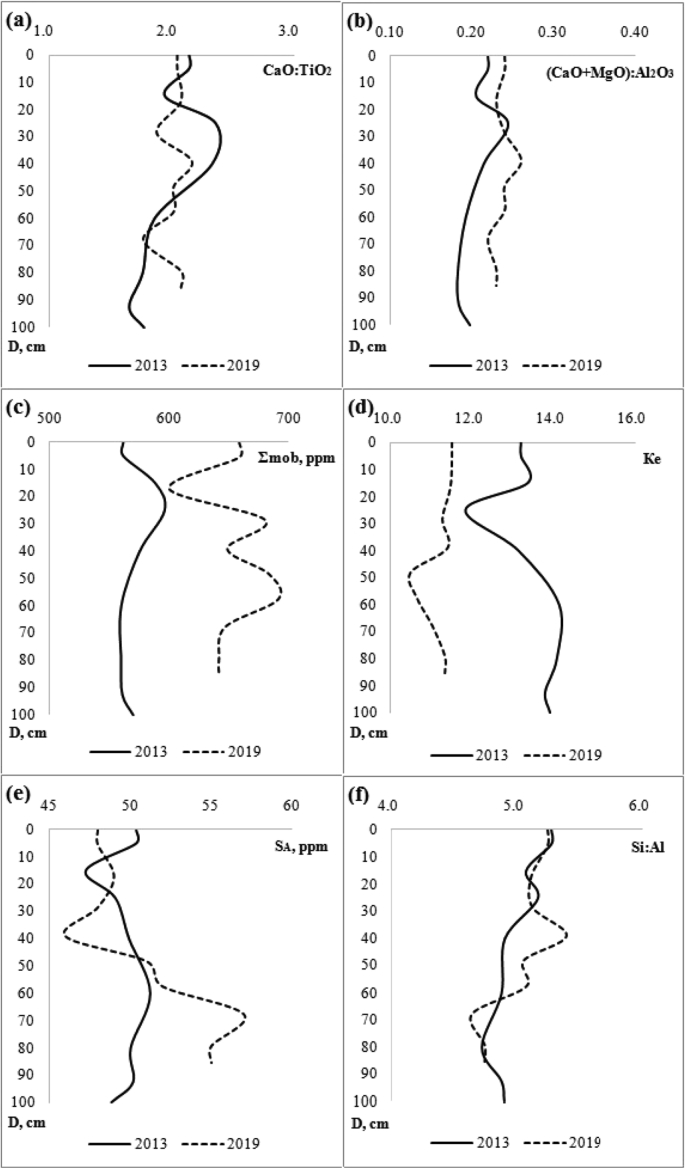
Distribution by profile of pedosediments of the geochemical relationships and coefficients (2013 and 2019).